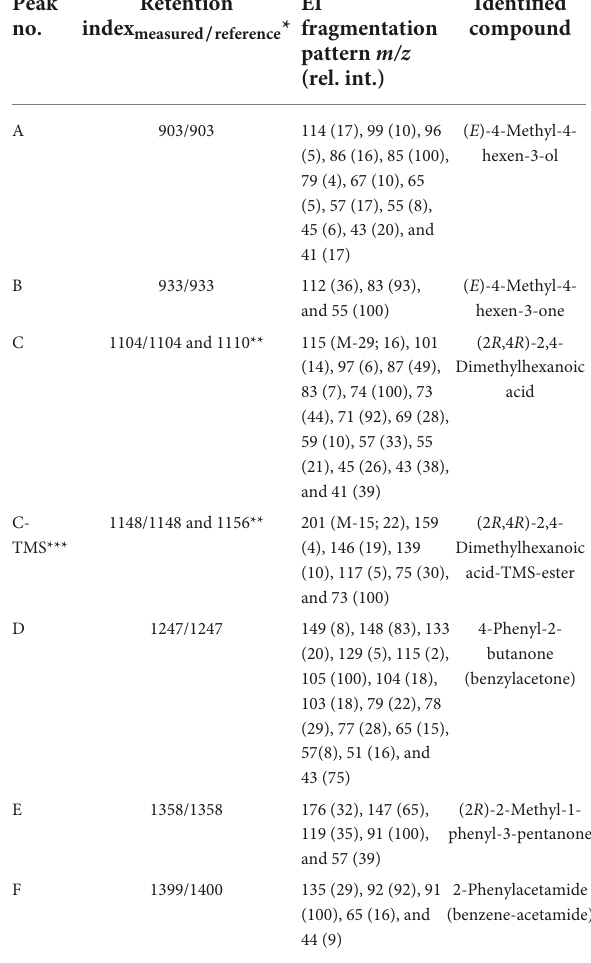
TABLE 3 Gas chromatographic-mass spectrometric data to the scent gland secretion components of Nelima spp. Peak